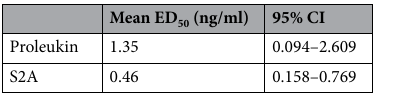
Table 2. Comparison of CTLL-2 proliferation assay parameters (n = 5).